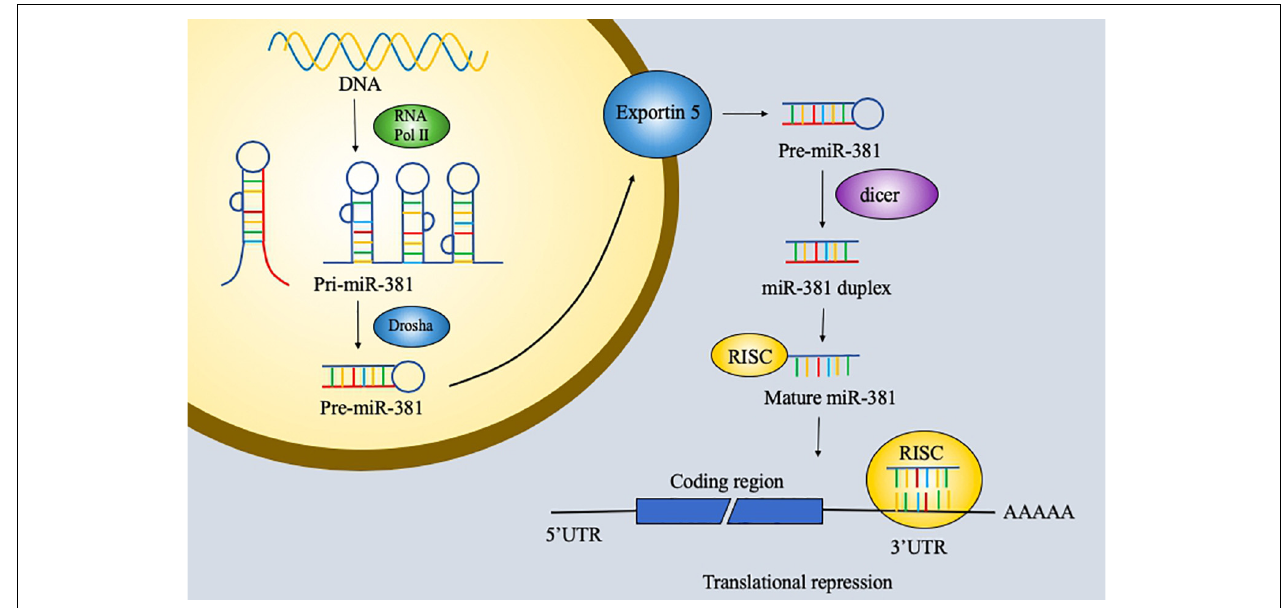
FIGURE 1 | The generation of microRNA (miR)-381 in cancer.